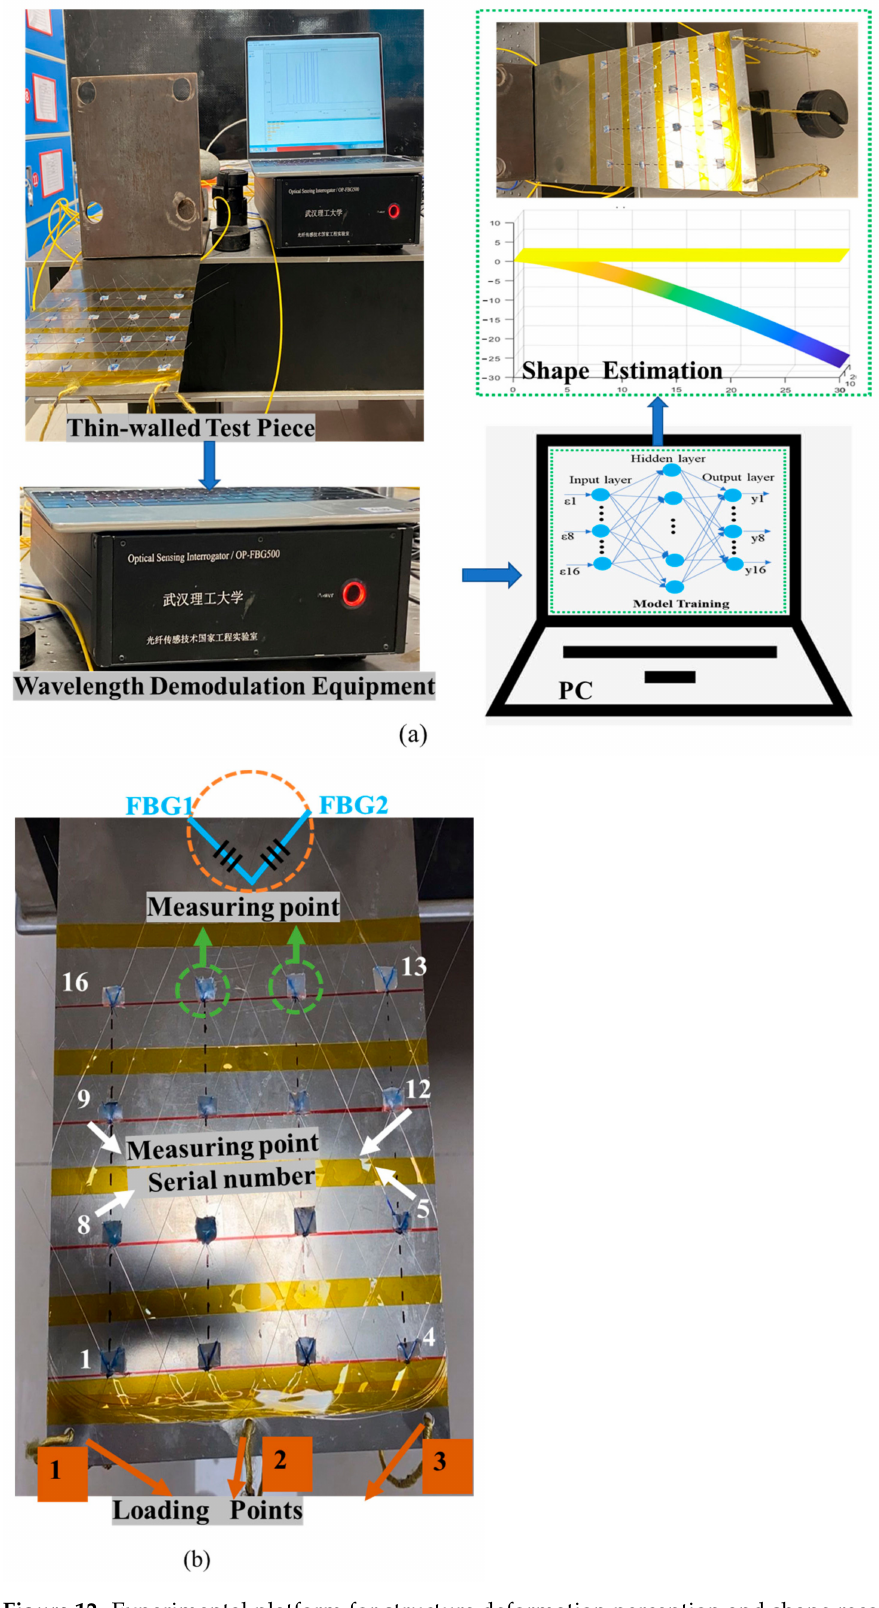
Figure 12. Experimental platform for structure deformation perception and shape reconstruction: ( a ) test platform; ( b ) sensor layout